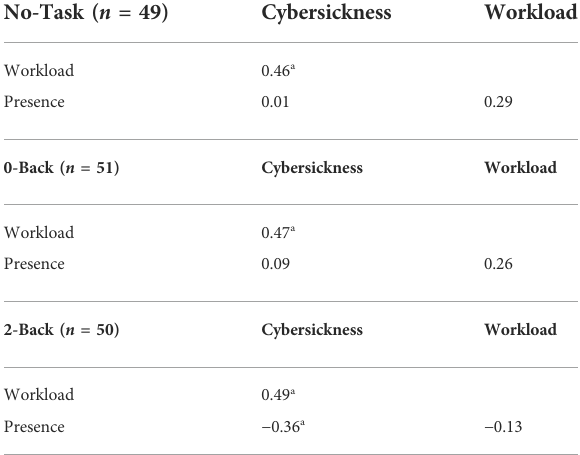
TABLE 2 Pearson ’ s product-moment correlations between cybersickness, workload, and presence by Group. No-Task ( n =